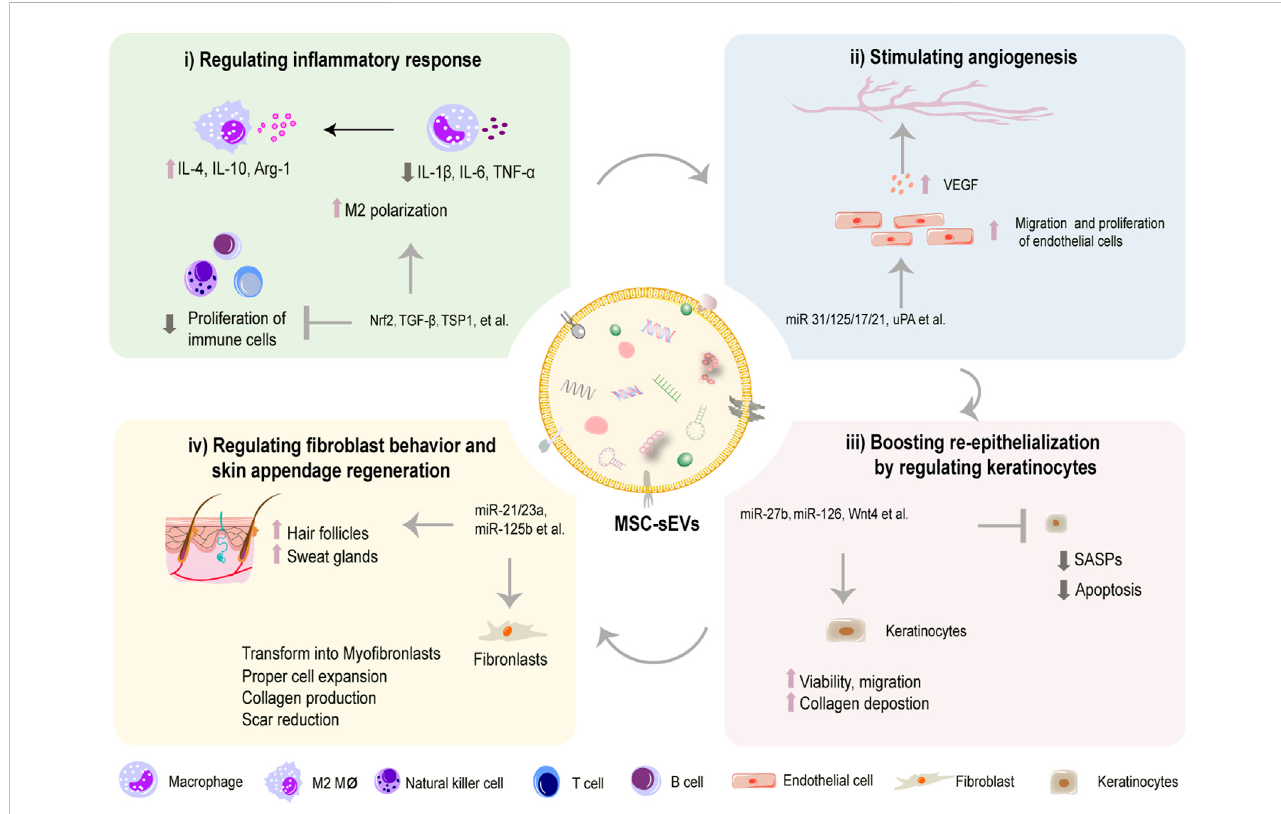
FIGURE 3 MSC-sEVs promote wound healing process by multiple mechanisms. MSC-sEVs can regulate in fl ammatory response by inhibiting proliferation of immune cells and shifting polarization of macrophages (i). MSC-sEVs stimulate angiogenesis by promoting VEGF-mediated migration and proliferation of endothelial cells (ii). MSC-sEVs boost re-epithelization by inhibiting SASPs and apoptosis and increasing the viability and migration of keratinocytes (iii). MSC- sEVs inhibit scar formation by modulating transformation of fi broblasts to myo fi broblasts